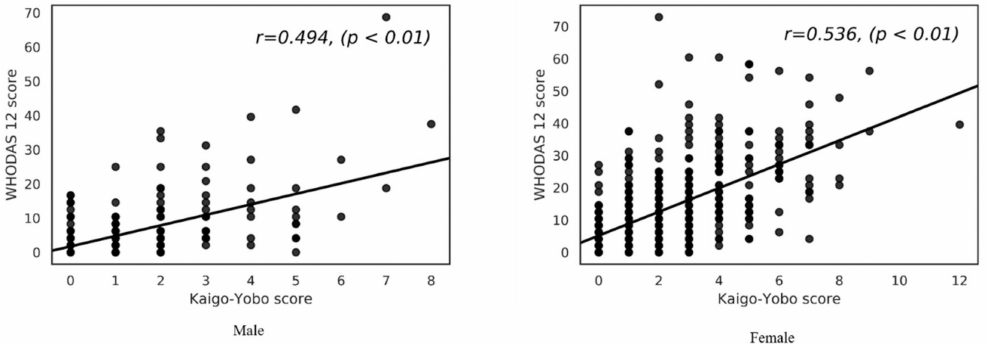
Figure 3. Association between Kaigo-Yobo and World Health Organization Disability Assessment Schedule-12